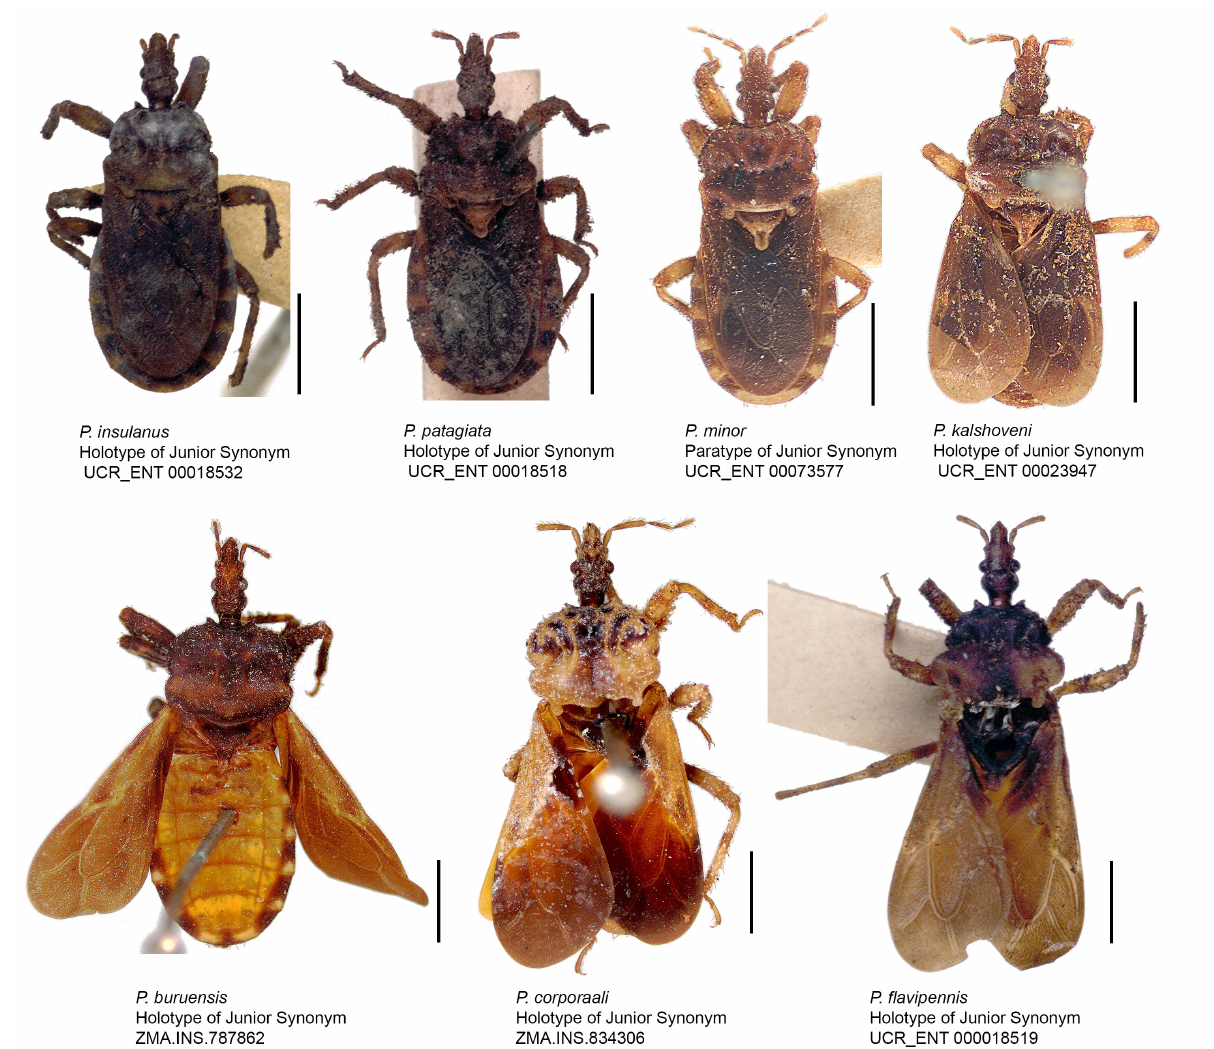
Fig. 16. Dorsal habitus images for junior synonym holotypes of species in Physoderes Westwood, 1845 (except P. minor = paratype). Scale bars = 2